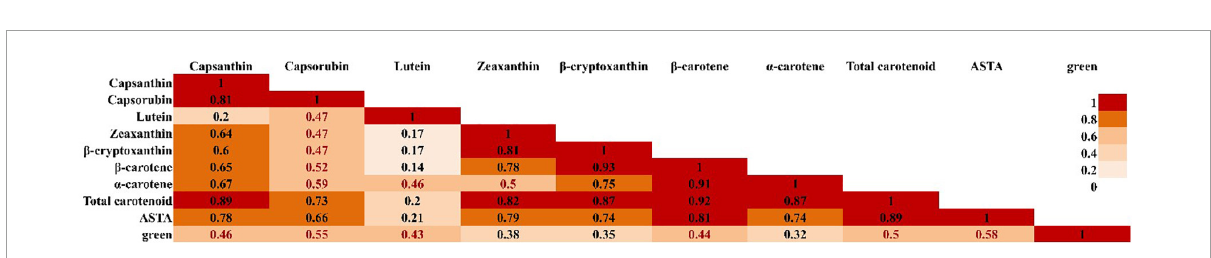
FIGURE3 Pearson correlation heatmap between carotenoid color pigments of fruit in LA RILs. In the figure, red color indicates a strong correlation coefficient and light orange indicates a weak correlation